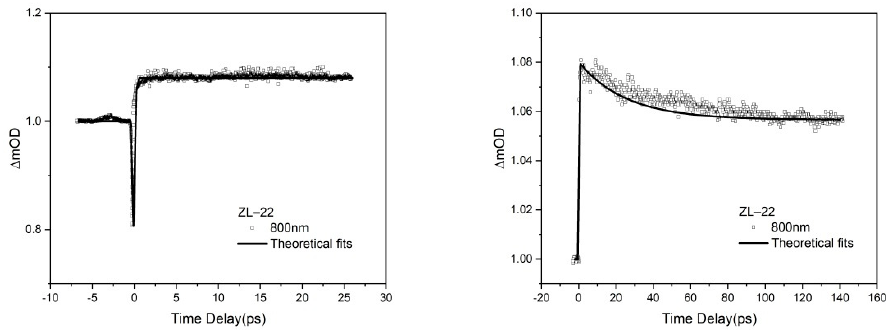
Figure 8. Photodynamic curves of ZL--22 in short--delay time and long--delay time at 800 nm.